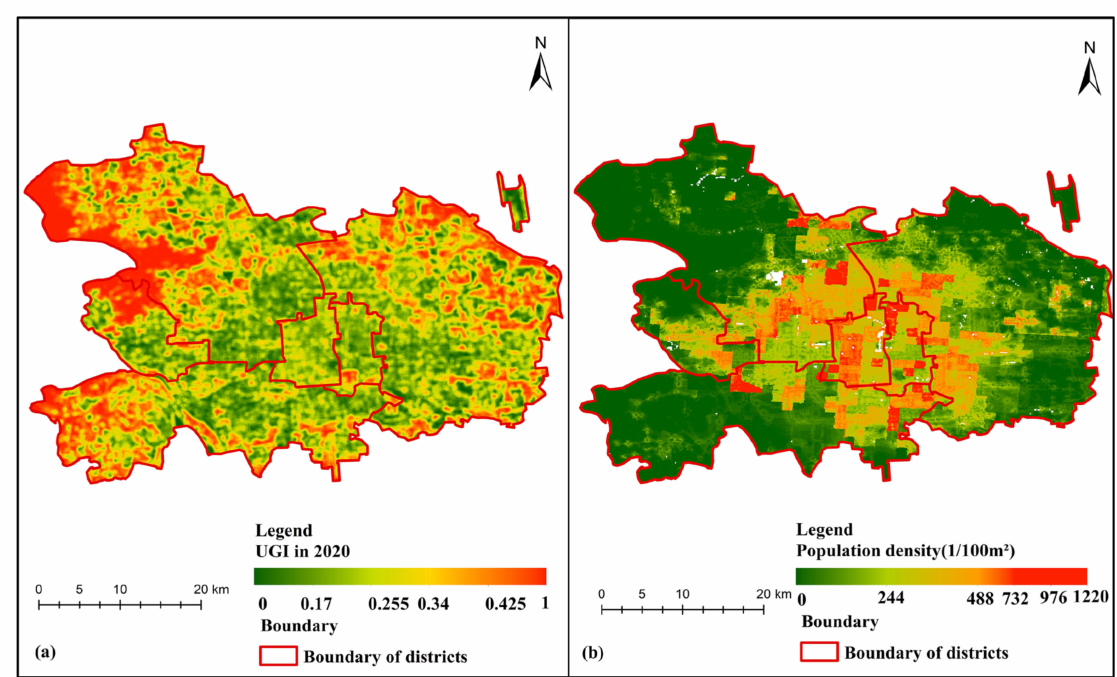
Figure 11. ( a ) Spatial distribution of UGI mapand ( b ) population density map for